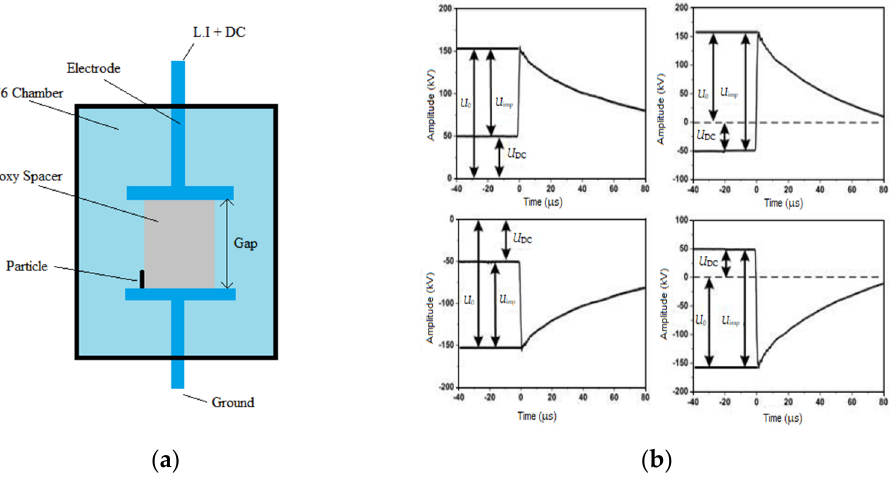
Figure 1. ( a ) Experimental setup with spacer and particle contamination in SF6 gas chamber; ( b ) applied superimposed voltage waveforms. Table 1. Notations used in the paper.